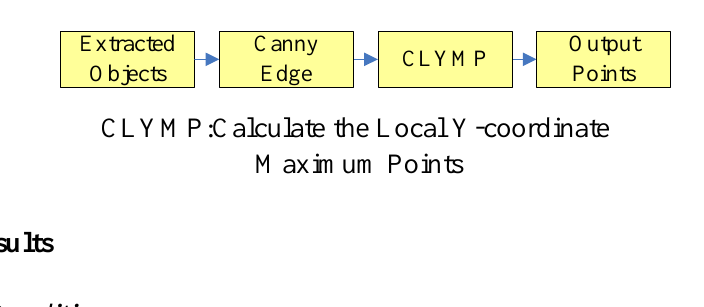
Figure 11. The flowchart of calculating the local Y-coordinate maximum